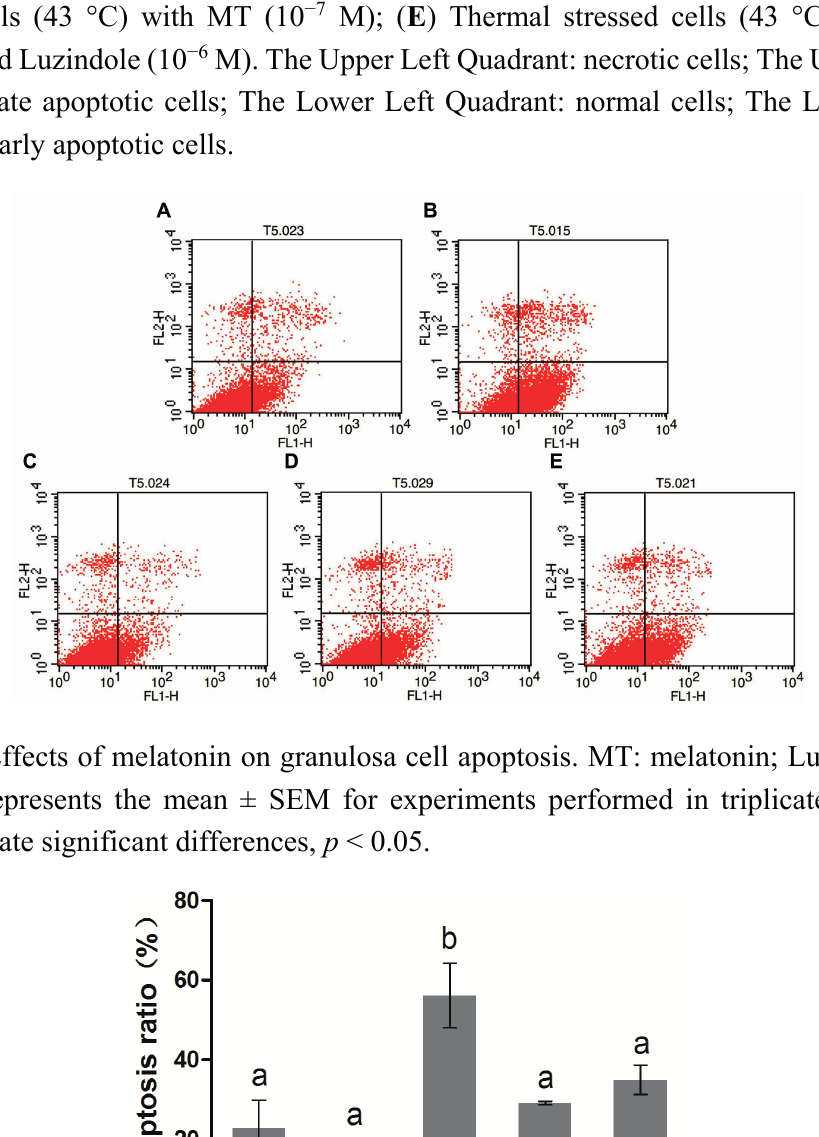
Figure 2. Low cytometry analysis of cell apoptosis. ( A ) Control cells (37 °C); ( B ) Control